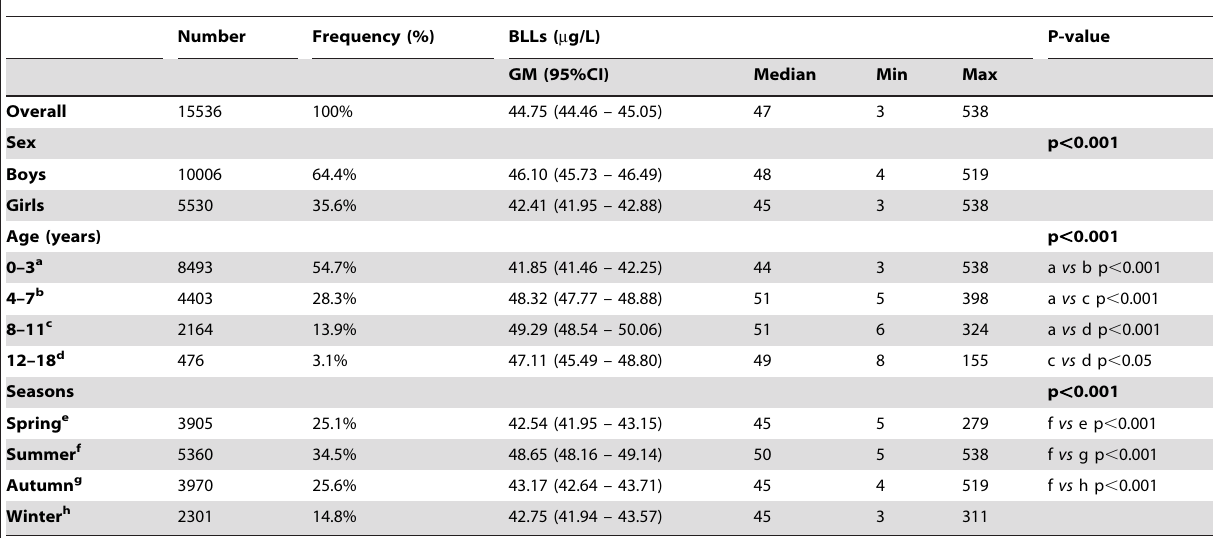
Table 1. Demographic characteristics and comparison of BLLs.